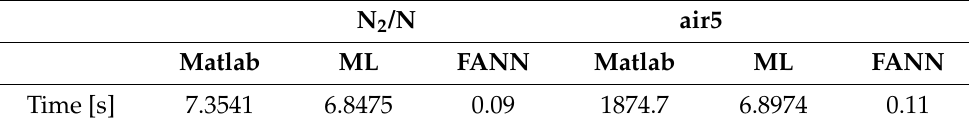
Figure 6. Comparison of Matlab and machine learning solution for the 1D reacting flow behind the shock wave in state-to-state approach for air5 mixture. Table 4. Comparison of time-to-simulation for Matlab and machine learning solutions for the same number of integration